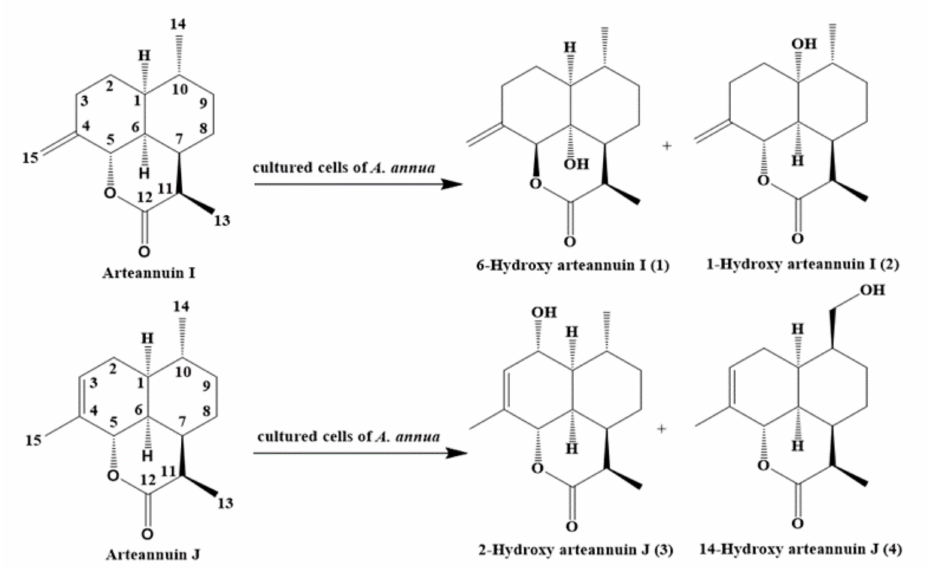
Figure 7. Proposed biotransformation scheme of arteannuin I/J in cultured cells of A. annua